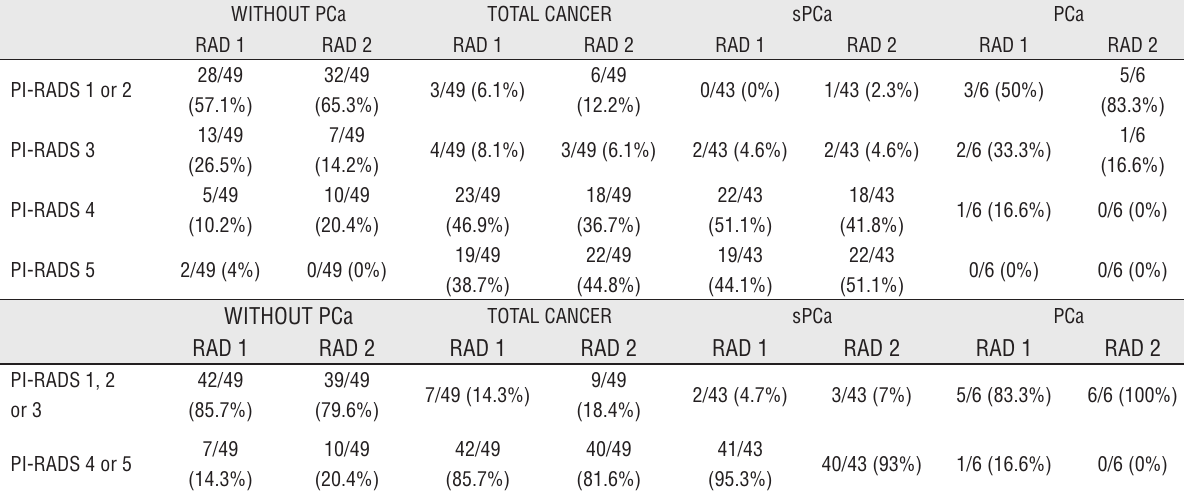
Table 4 - Distribution of PIRADS classification in each